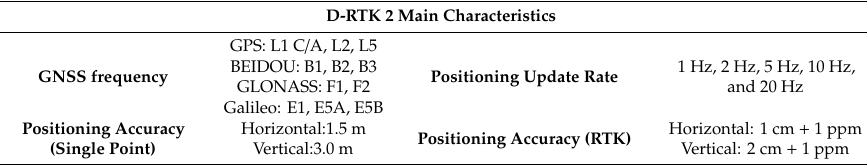
Table 4. Main characteristics of the DJI D-RTK 2